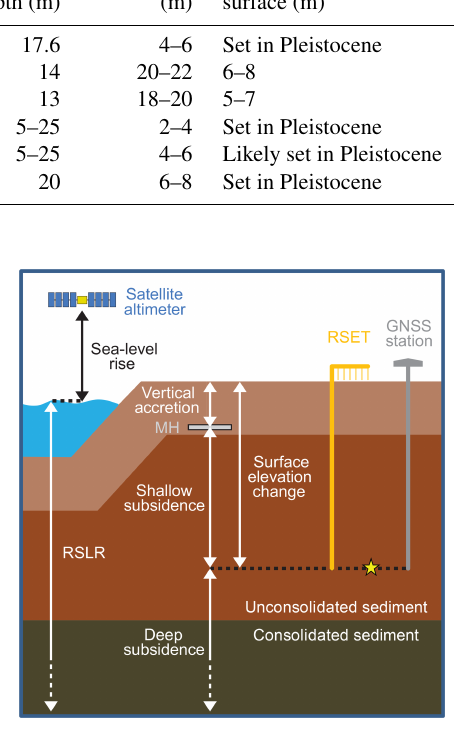
Table 4. Benchmark foundation depths and local depth to the Pleistocene surface for tide gauges in the Netherlands. Benchmark depths from Rena Hoogland, personal communication, 2018. Pleistocene surface depths are from Vos et al. (2011). Depth to Benchmark Benchmark Pleistocene foundation height foundation surface above Pleistocene Tide-gauge name Latitude depth (m) (m) surface (m)